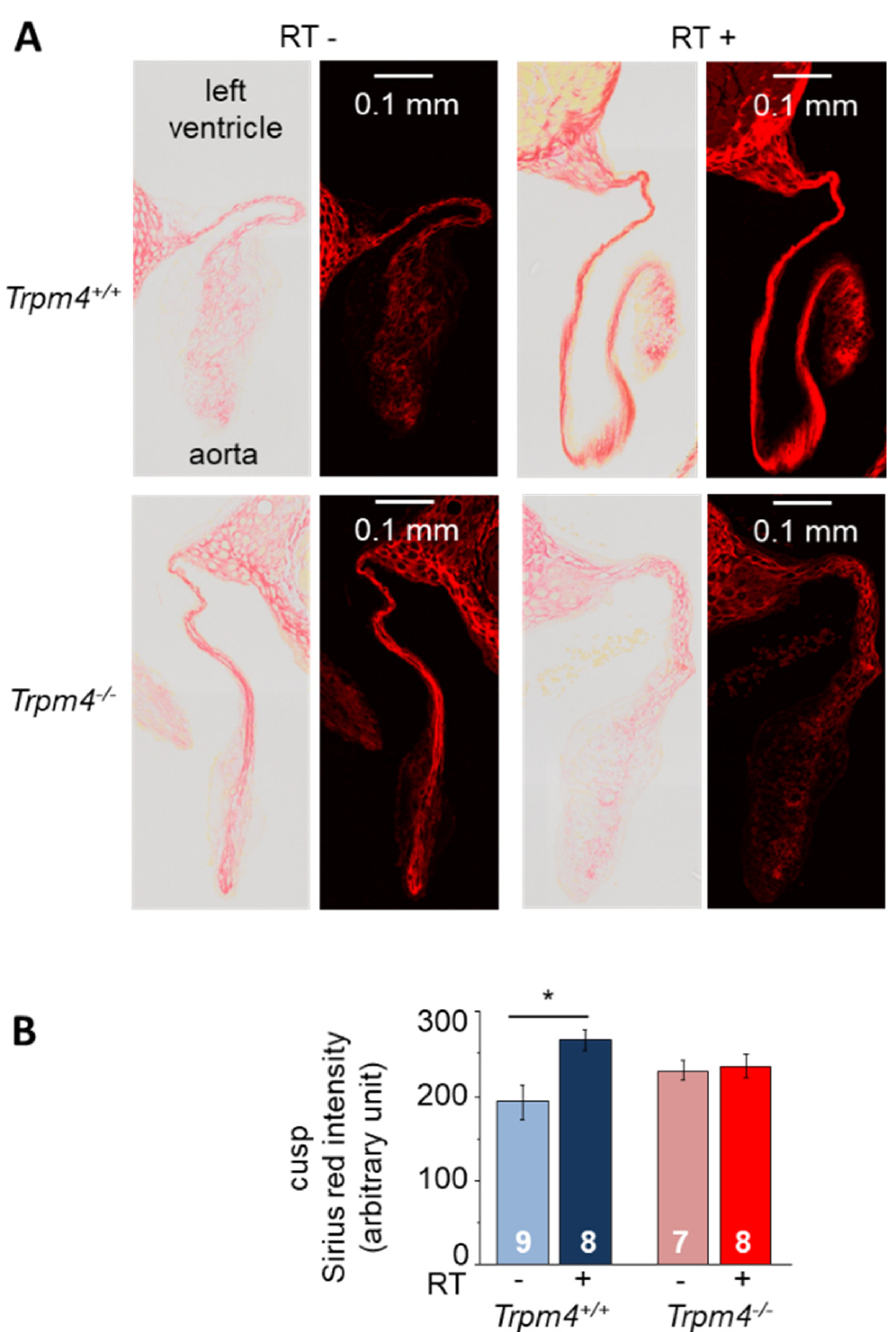
Figure 6. Effect of irradiation on valvular cusp fibrosis. ( A ) Histological slices performed at 5 months post-treatment in the longitudinal axis (3 µ m thickness) of the aortic valve representative for each group, stained with Sirius red to reveal fibrosis. For each group, the figure shows the original image with full colors ( left panel ) and the same image with only red chromaticity (see methods) to precisely isolate Sirius red staining. For each panel, the left ventricle is on the upper side and the aorta on the lower side. ( B ) Cusp red chromaticity intensity for each group in arbitrary units (see methods for quantification protocol). Histograms indicate the mean ± S.E.M. for each group. * indicates a significant difference between groups ( p < 0.05).